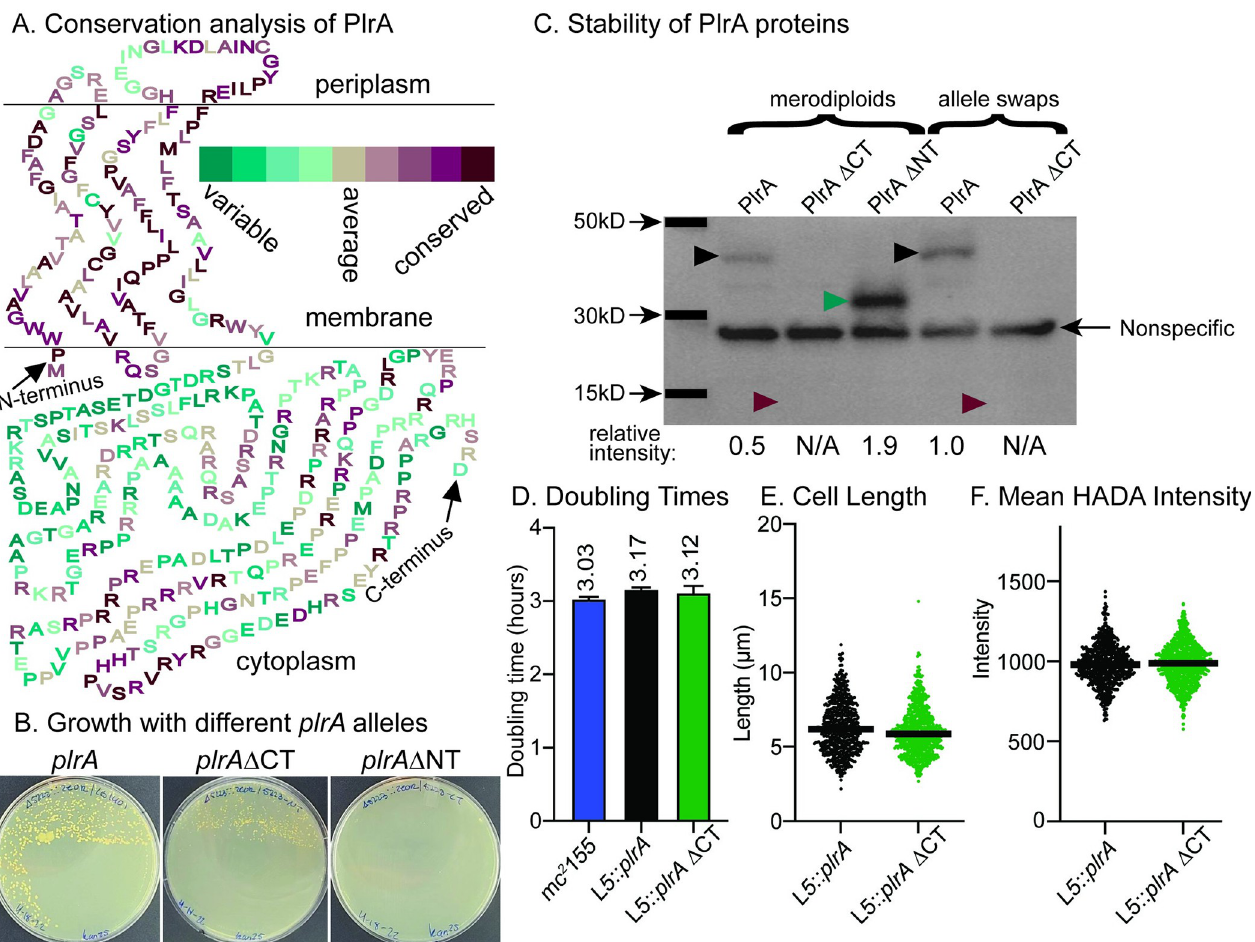
Fig 3. The C-terminal domain of PlrA is dispensable. A) PlrA protein sequence arranged in either periplasmic, membrane or cytoplasm as predicted by TMHMM. Amino acids are colored according to conservation as measured by Consurf analysis. B) Plates resulting from L5 allele swapping of the wild-type plrA with full-length plrA- strep, or plrA Δ CT-strep or plrA Δ NT-strep. The experiment was arranged so that the original, wild-type allele is lost in any surviving colonies–see Material and Methods for details. C) Western blot of Msmeg strains carrying either plrA- strep, plrA Δ CT-strep and plrA Δ NT-strep as merodiploids or allele swaps. PlrA - strep is 43kD and is indicated with black arrowheads, PlrA Δ CT-strep is 13kD, and its expected location is indicated with maroon arrowheads, PlrA Δ NT strep is 31kD, and is indicated with a teal arrowhead. Densitometry of the PlrA-strep bands was used to calculate the relative band intensities of each band compared to the WT PlrA-strep allele swap–shown at bottom of gel image. N/A indicates that the band was not apparent. D) Doubling times calculated from growth curves in 7H9 of the mc 2 155 parent, Δ plrA L5:: plrA- strep, and Δ plrA L5:: plrA Δ CT - strep strains. E) Cell lengths of the Δ plrA L5:: plrA- strep, and Δ plrA L5:: plrA Δ CT - strepstrains in log. phase, as quantified from phase microscopy images by MicrobeJ analysis. F) Average HADA intensity per cell of cells from E.